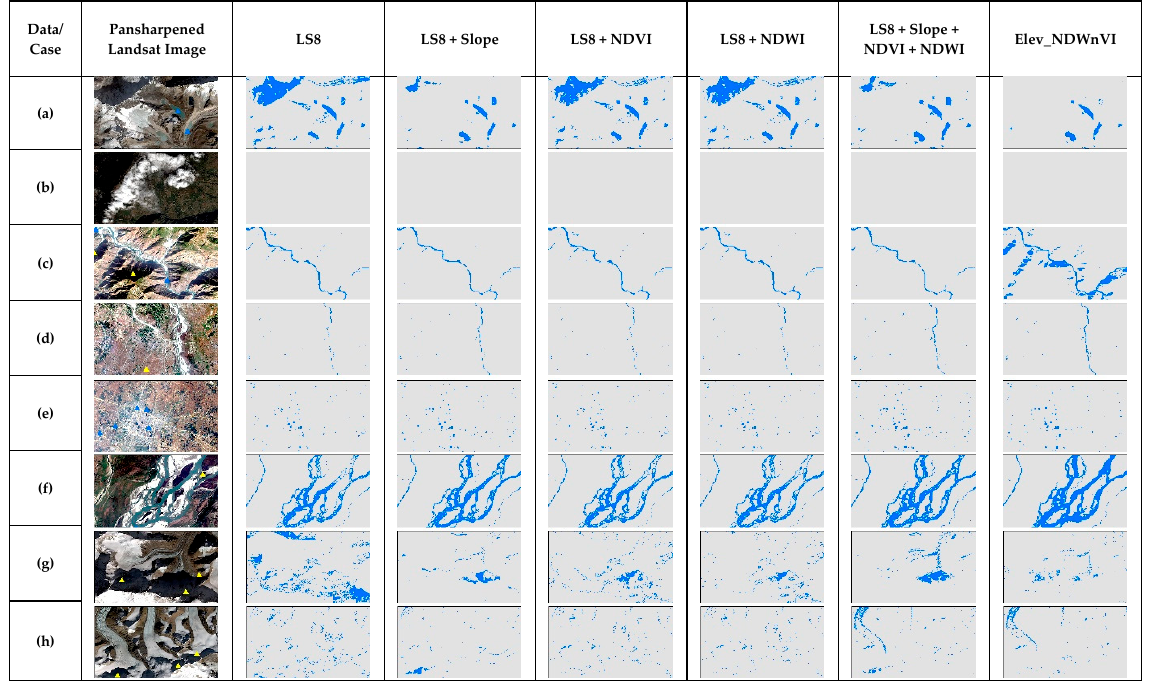
Figure 10. The comparison of RF results of special cases of surface water in the test scene (Figure 1) for different multiband data used.